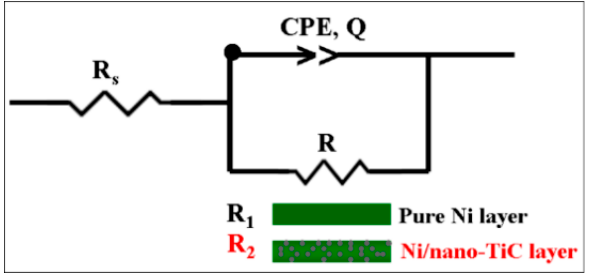
Figure 7. Equivalent electrical circuit representing the pure Ni and Ni/nano-TiC layers immersed in LiOH-H 3 BO 3 solution.